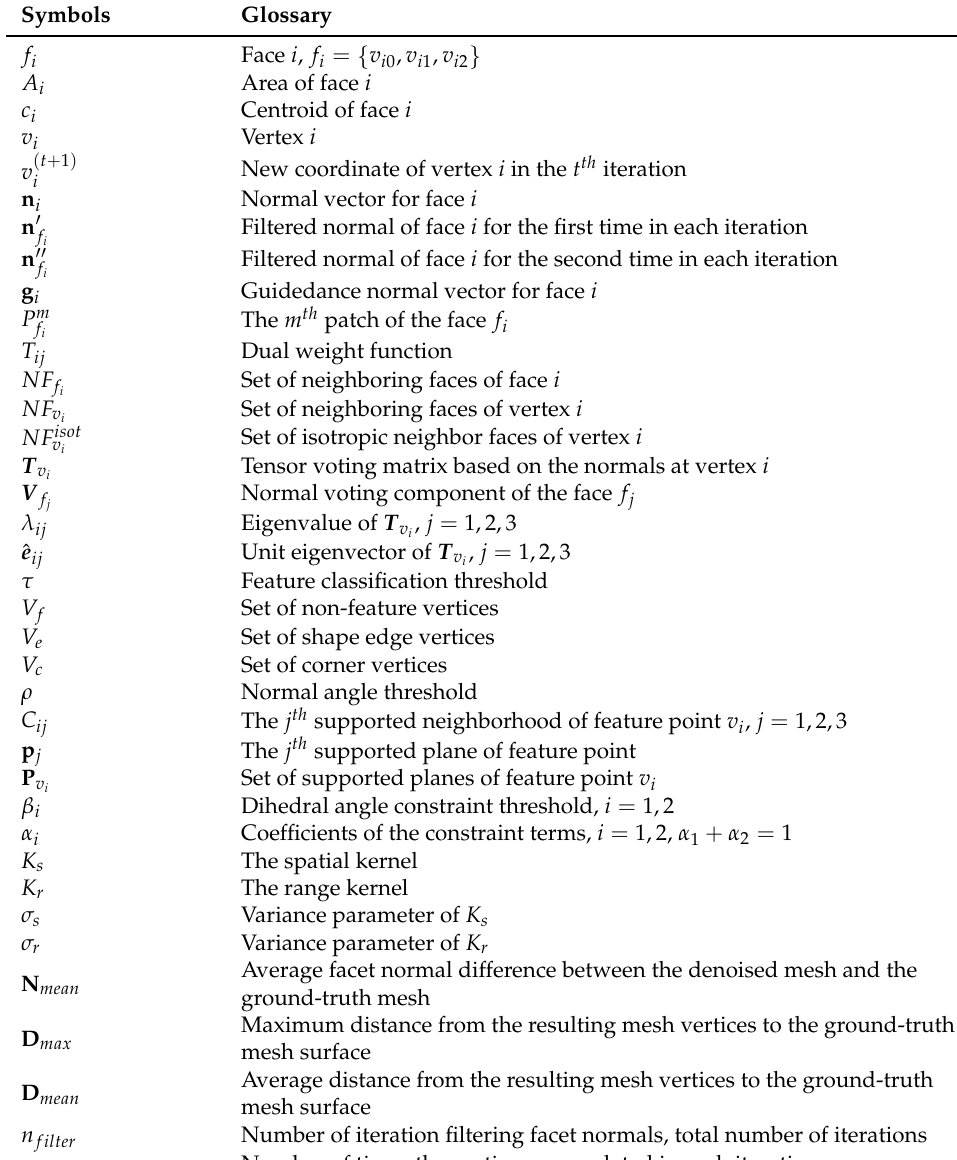
Table 1. Summary of